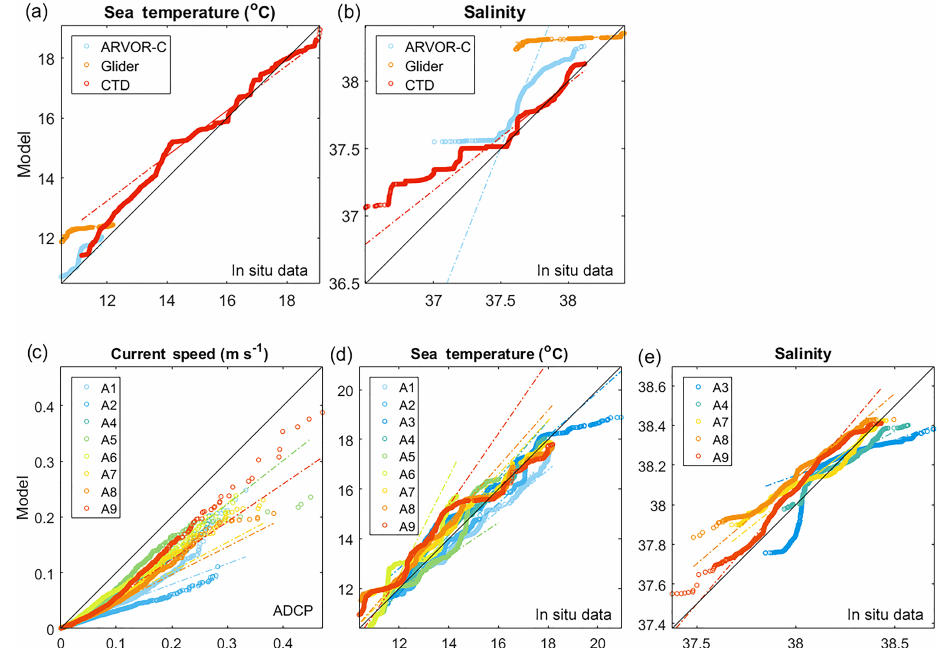
Figure 9. Model-to-observation Q – Q plots of (a) temperature and (b) salinity measured by CTD, ARVOR-C profiling float and glider, and (c) current speed, (d) temperature and (e) salinity measured at the bottom of stations A1 to A9. In addition to the dataset distribution, dash–dot lines fit the second and third quartiles of each Q – Q distribution, while the black line corresponds to the model–observation